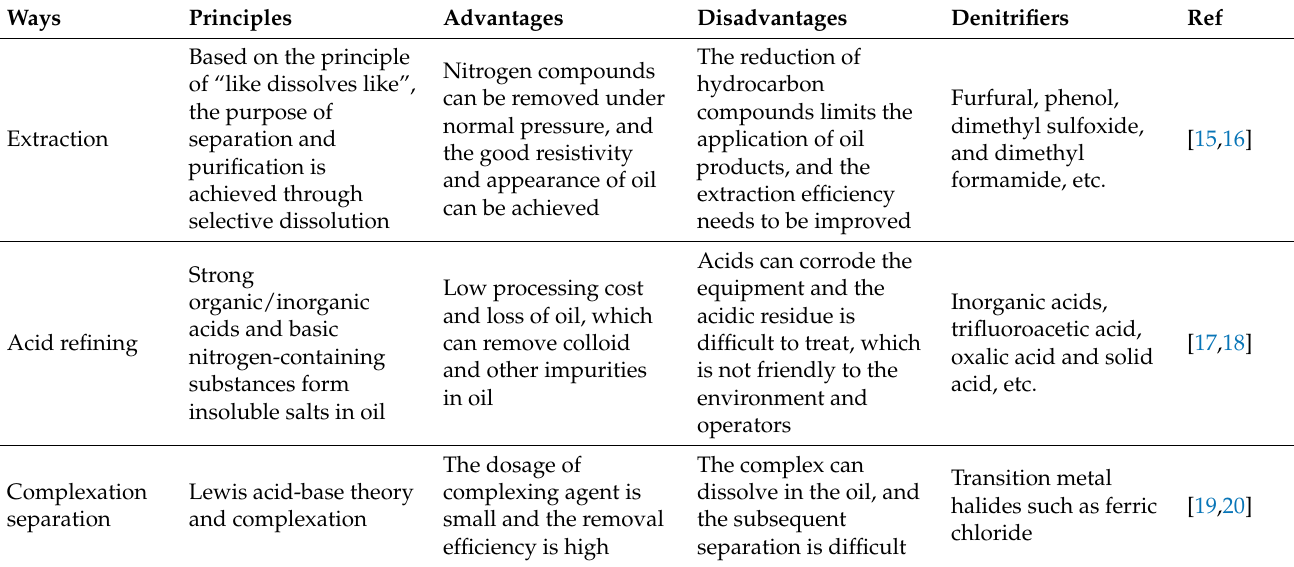
Table 1. Comparison of non-hydrodenitrogenation